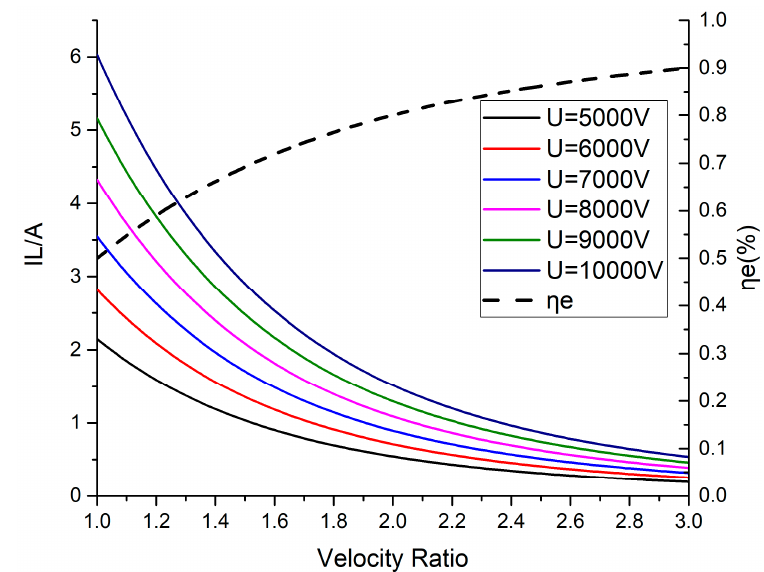
Figure 1. Effect of the velocity ratio variation on limiting current with different beam voltage. Figure 1. E ff ect of the velocity ratio variation on limiting current with di ff erent beam